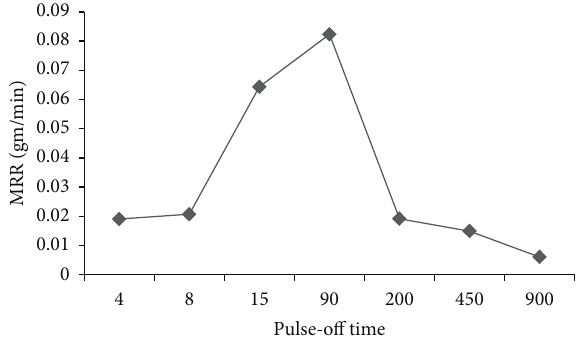
Figure 8: Electrodischarge machined workpiece.